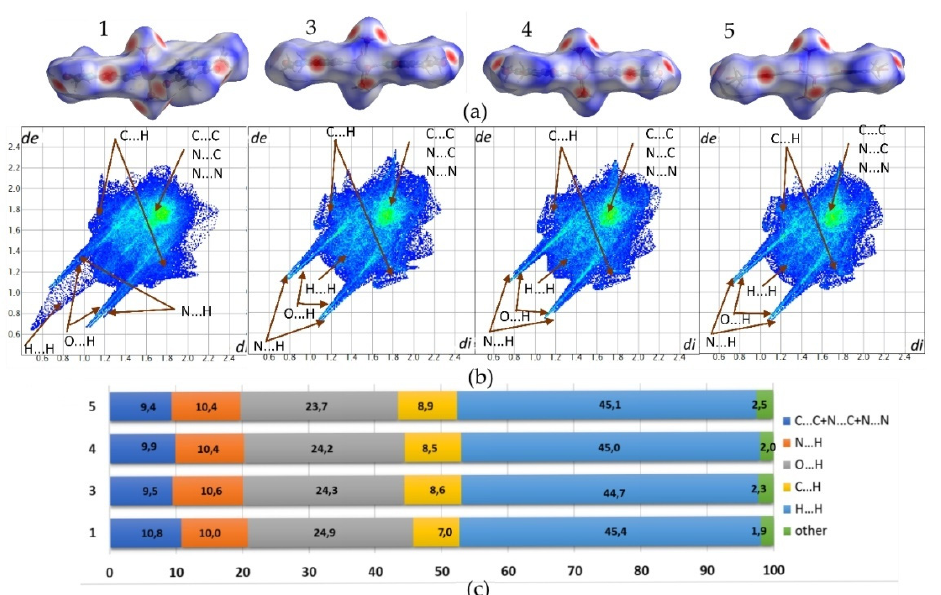
Figure 4. ( a ) Molecular shapes of 1 and 3 – 5 visualized as Hirshfeld surfaces; ( b ) Fingerprint plots generated for single molecules. Labels indicate regions of specific interatomic interactions; and, ( c ) The percentage contributions to the Hirshfeld surface areas for major intermolecular contacts.